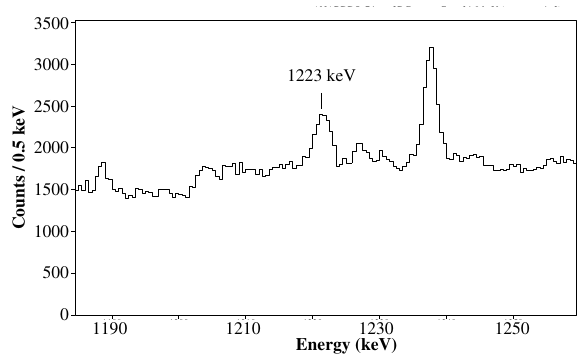
Figure 2. Sum spectrum of the forward-ring detectors, taken at a distance of 74 µ m. The stopped peak component from the 2 + 0 + transition of 98 Zr is marked. The Doppler-shifted component 1 is not distinguishable from the background. (From